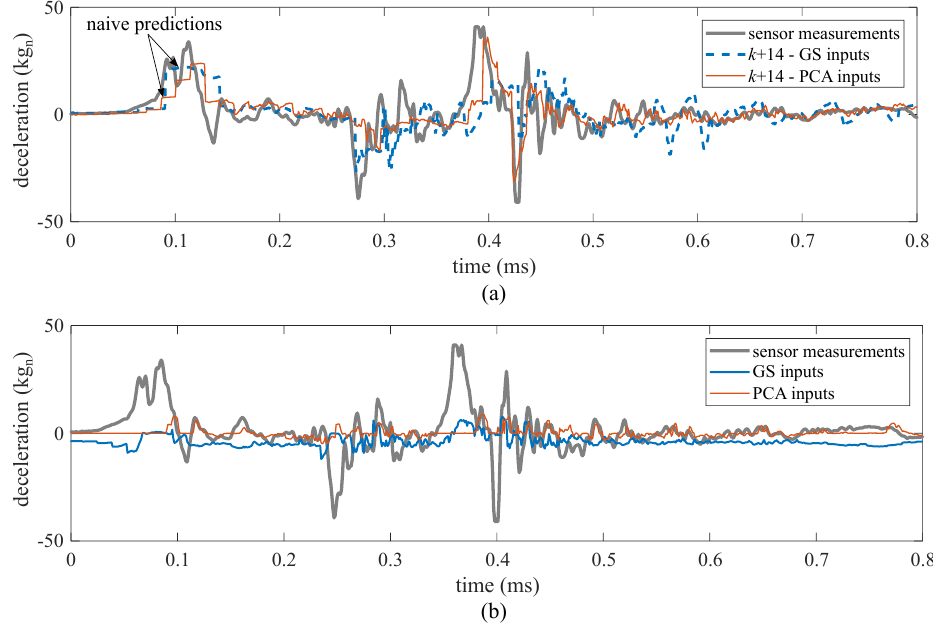
Figure 9. Prediction performance for 14 steps ahead, “PCA inputs” versus “GS inputs”: ( a ) prediction; and ( b ) scaled typical feature extracted by the LSTMs using τ = 11 under both